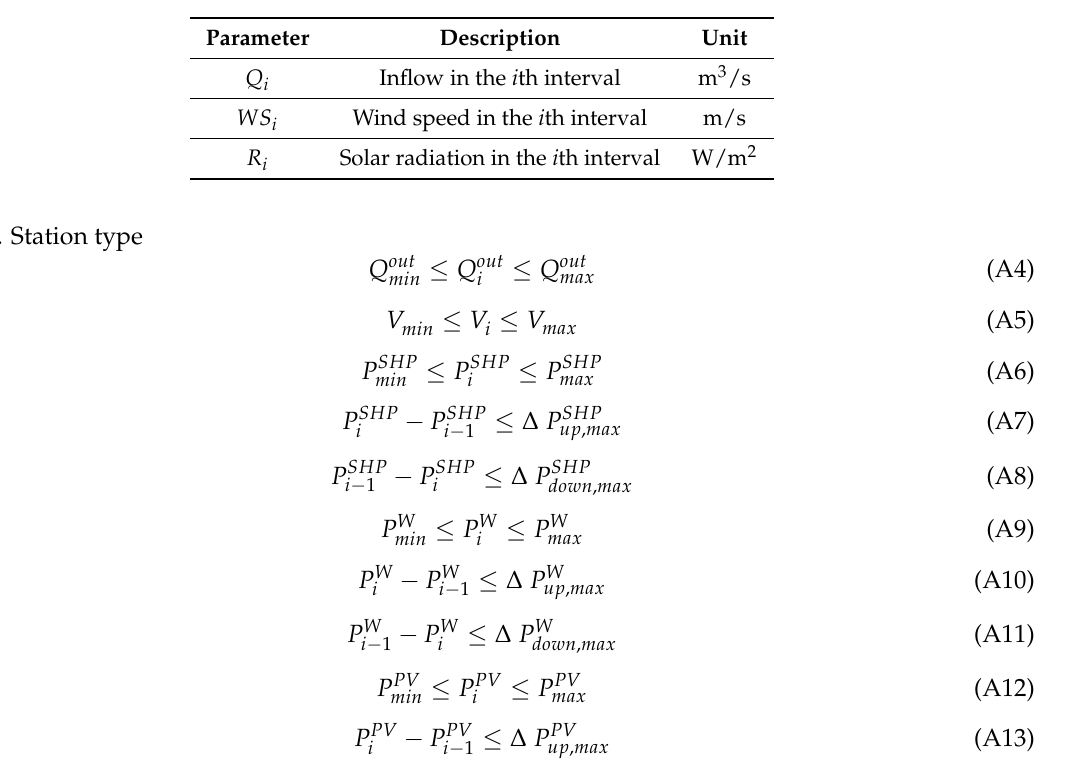
Table A4. Parameters of constraints of